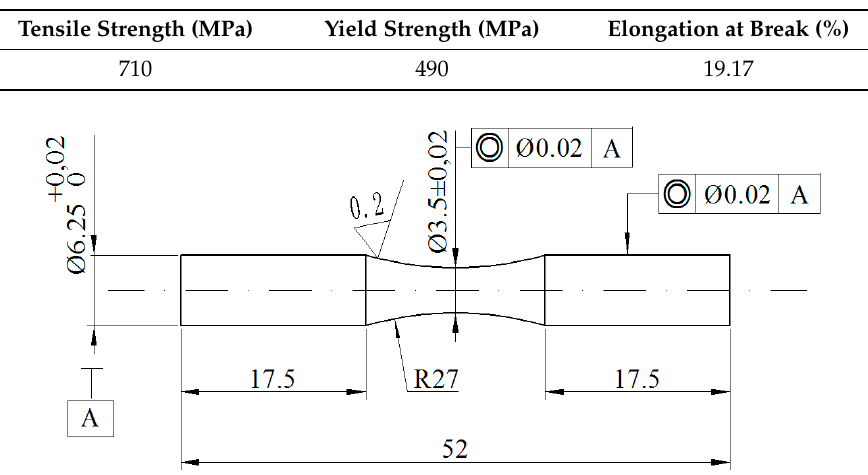
Table 2. Mechanical properties of the medium carbon steel.